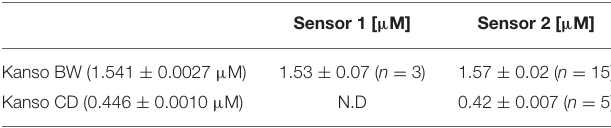
TABLE 1 | Analysis of Kanso Certified Reference Material (CRM) using Sensors 1 and 2.